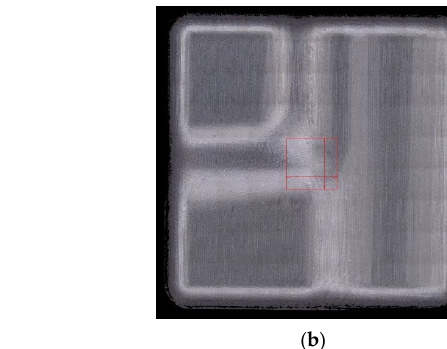
Figure 8. 3D micro coordinate measurement system ( a ) Alicona Infinite Focus G5 ( b ) sample for measurement. Real machined surface is presented in Figure 9.